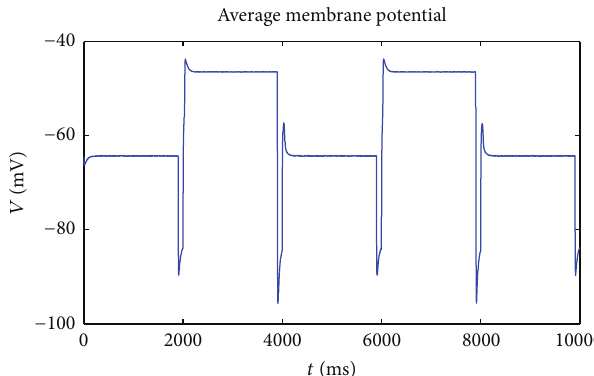
Figure 1: Add brief outward current pulses (lasts 0.1s, every 2s, 7.2 𝜇 A/cm 2 ).